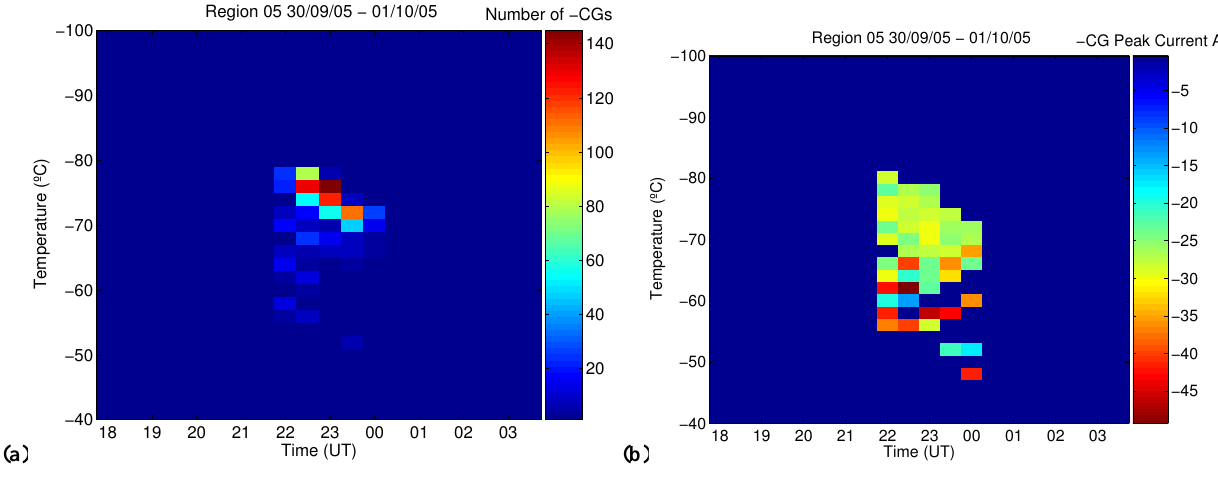
Fig. 10. Temporal spectrograms of CG occurrence rate (a) and peak current (b) as a function of cloud top temperature, 30 September–1 October 2005.